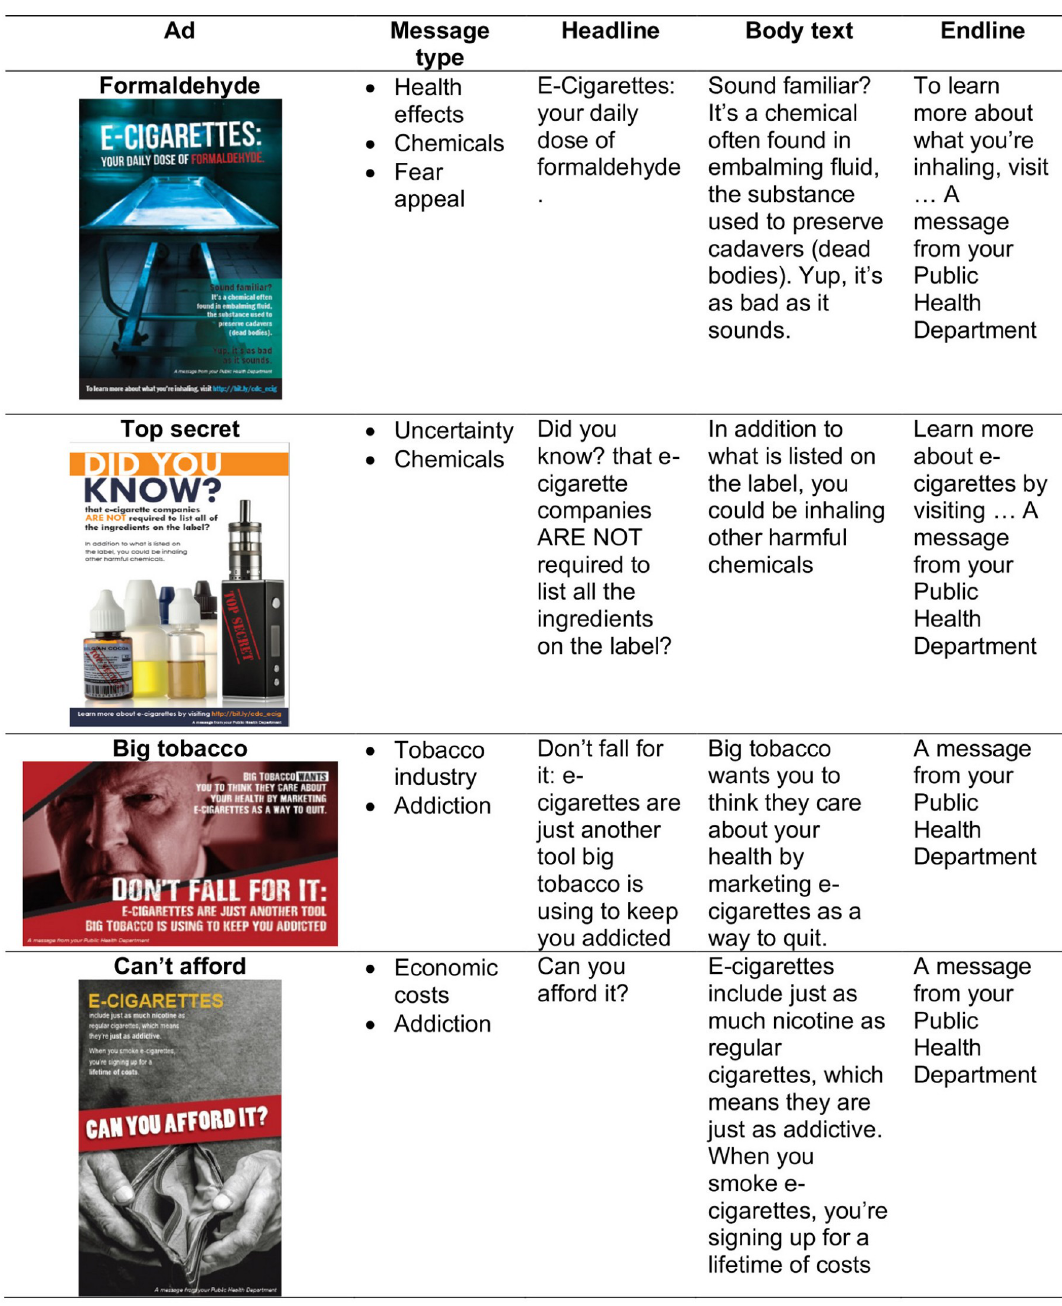
outcomes were selected based on previous literature as described in the next section. At the end of the survey, all participants saw a debriefing page stating that the messages were used for research only and had not been approved by any public health or federal agency. All partici- pants were given a quitline telephone number and referred to smoking cessation websites.